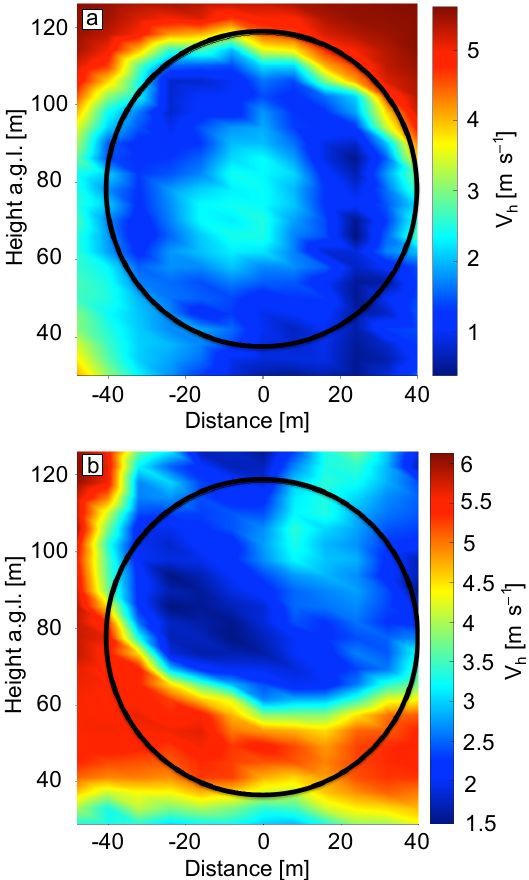
Figure 13. The wind speed (10min averaged) wake in a vertical plane one rotor diameter away from the turbine observed with the vertical plane scans performed by the short-range WindScanner sys- tem: (a) wake pulled down (measurements taken on 12 May 2015 from 00:40 to 00:50UTC); (b) wake lifted up (measurements taken on 12 May 2015 from 19:10 to 19:20UTC). Black circle, rotor- swept